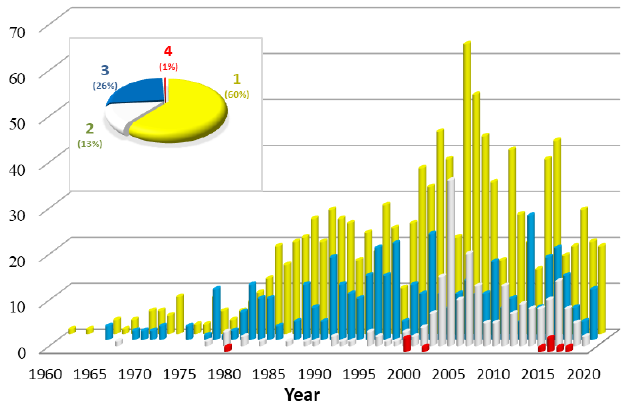
Figure 1. Number of structures per year published for compounds I – IV since 1960 (ConQuest 2.0.4– CSDS 2020–V.